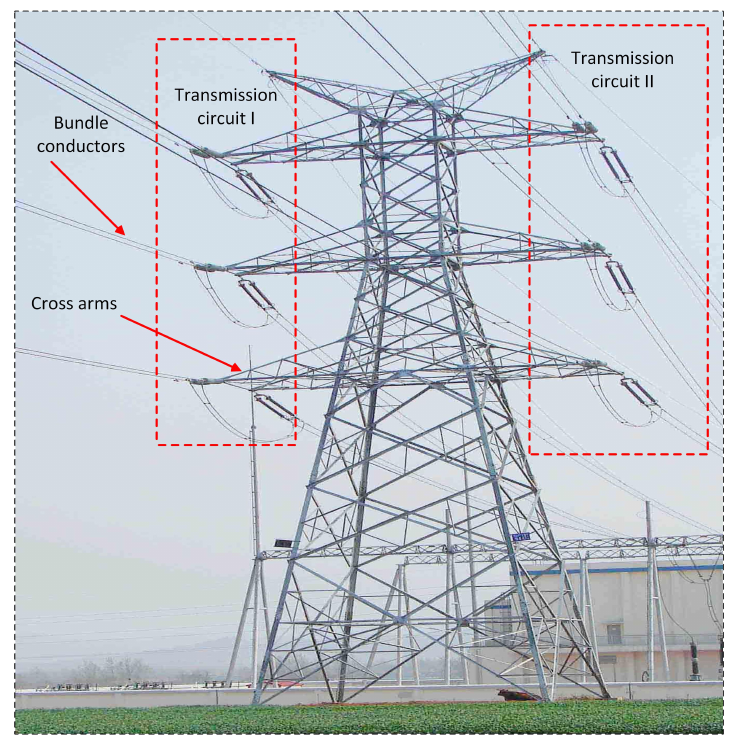
Figure 2. A typical transmission line tower. Source: Adapted from the work in